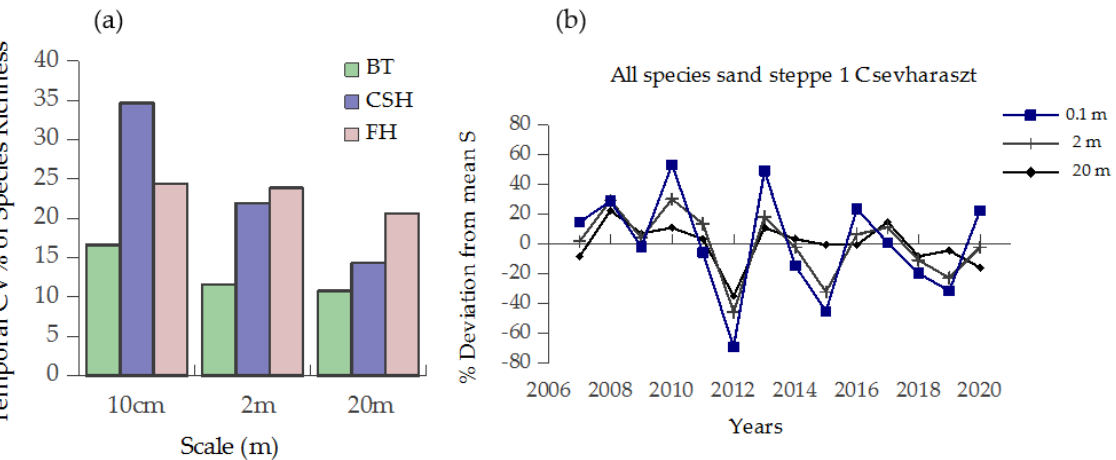
Figure 6. Scale-dependent relative temporal variance of species richness. ( a ) Temporal CV% (coeffi- cient of variation) of species richness at the three study sites. BT = Battonya site (loess meadow steppe), CSH = Csévharaszt site (sand steppe 1), FH = Fülöpháza site (sand steppe 2) estimated at three different scales. ( b ) Scale dependence of percentage deviation from mean species richness over time. Example observed in sand steppe at Csévharaszt.